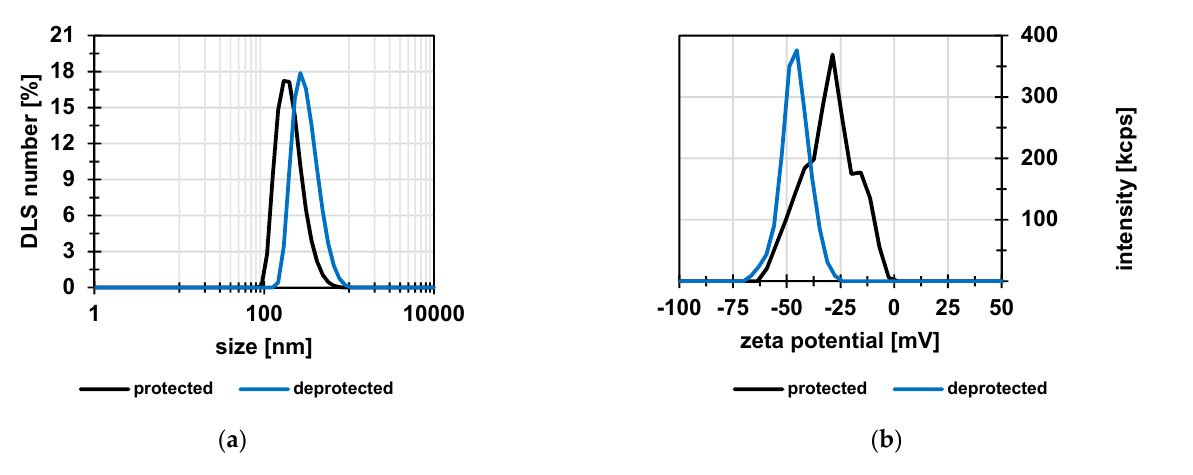
Figure 3. Comparison of protected and deprotected particles: ( a ) size; ( b ) zeta potential (kcps = kilo counts per seconds); data are shown for one of the three independent measurements (Table 1).